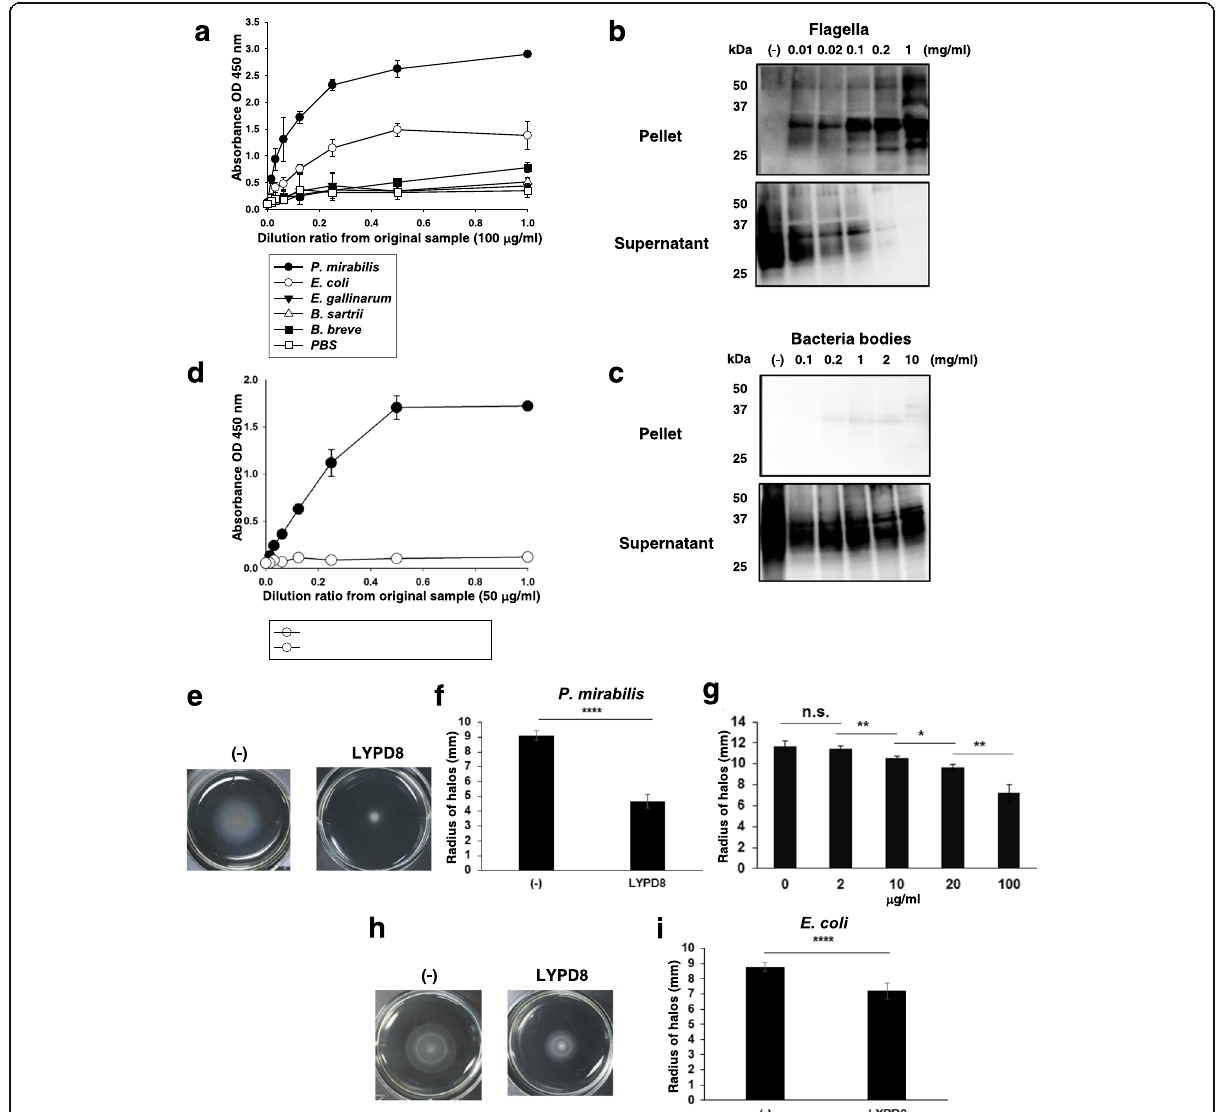
Fig. 4 Function of the hLYPD8 protein generated by a Pichia pastoris expression system. a ELISA assay for binding of soluble hLYPD8 protein from P. pastoris to the indicated species of intestinal bacteria. b, c Immunoblot analysis with anti-FLAG antibody for the supernatant and pellet of the mixture of soluble hLYPD8 protein and a gradient dose of flagella ( b ) or bacterial bodies ( c ) from P. mirabilis. d ELISA assay of LYPD8 binding to flagella of P. mirabilis . e, f Motility of P. mirabilis in semisolid agar with or without soluble hLYPD8 protein. Representative photos are shown ( e ). The radii of motility halos were measured at 4 h ( f ). Data are mean ± s.d. ( n = 6 per group). g Motility of P. mirabilis in semisolid agar with a gradient concentration of soluble hLYPD8 protein. The radii of motility halos were measured at 4 h. Data are mean ± s.d. ( n = 6 per group). h, i Motility of E. coli in semisolid agar with or without soluble hLYPD8 protein. Representative photos are shown ( h ). The radii of motility halos were measured at 4 h ( i ). Data are mean ± s.d. ( n = 6 per group). * p < 0.05, ** p < 0.01, **** p < 0.001. n.s. not